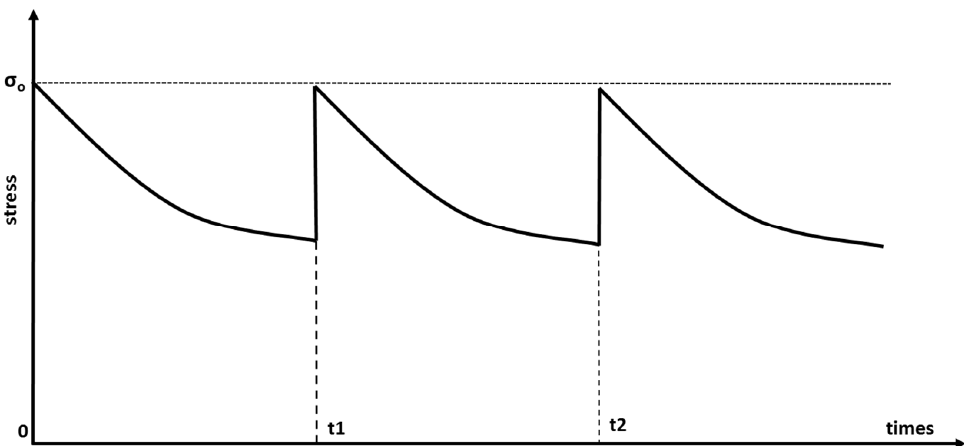
Figure 1. Cyclic stress versus time relation [30].